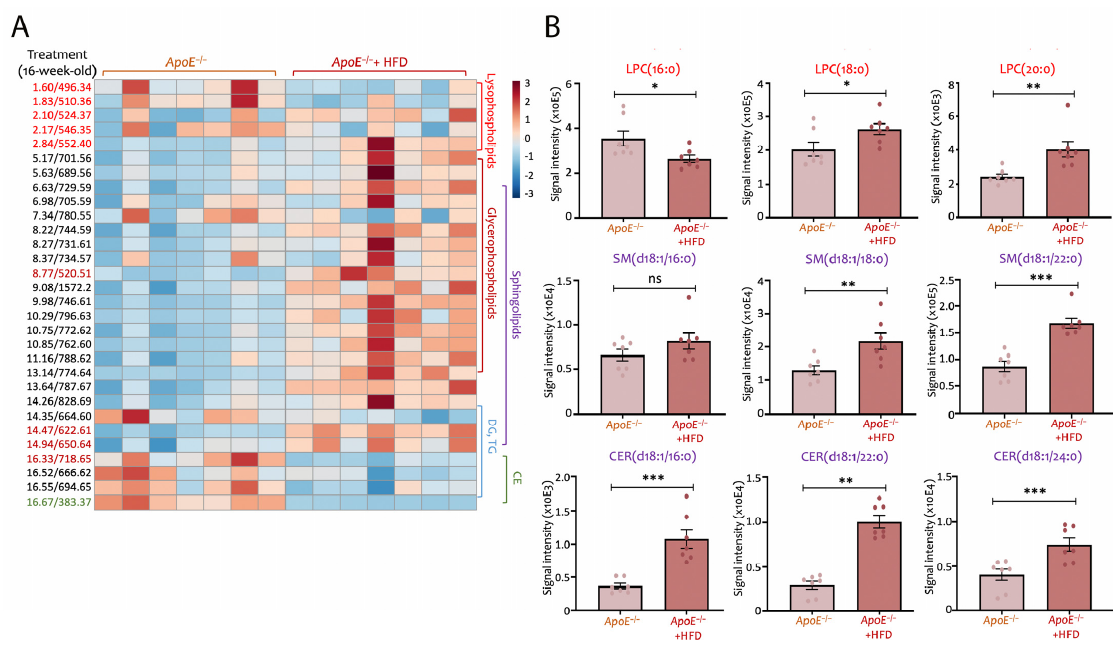
Figure A2. High-fat diet-fed apoE − / − mice show enhanced levels of sphingomyelin and ceramide. Data was presented in ( A ) a heatmap and ( B ) bar plots with dots in signal intensity. Similar to Figure 3, the 16-week-old mice showed that LPC(16:0), LPC(18:0) and SM(d18:1/22:0) remain the most dominant LPC and sphingolipid species in the plasma, respectively. *** p < 0.001, ** p < 0.01, * p < 0.05, ns: not significant between groups. Abbreviations: apoE − / − : apolipoprotein E knockout; LPC: lysophosphatidylcholine; SM: sphingomyelin; CER: ceramide; HFD: high-fat diet.